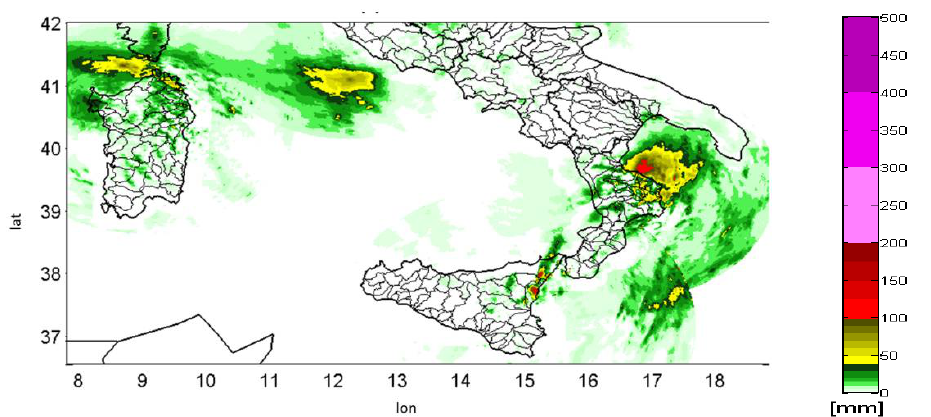
Figure A7. Example of the difference between GRISO interpolation on radar and rainfall field. This